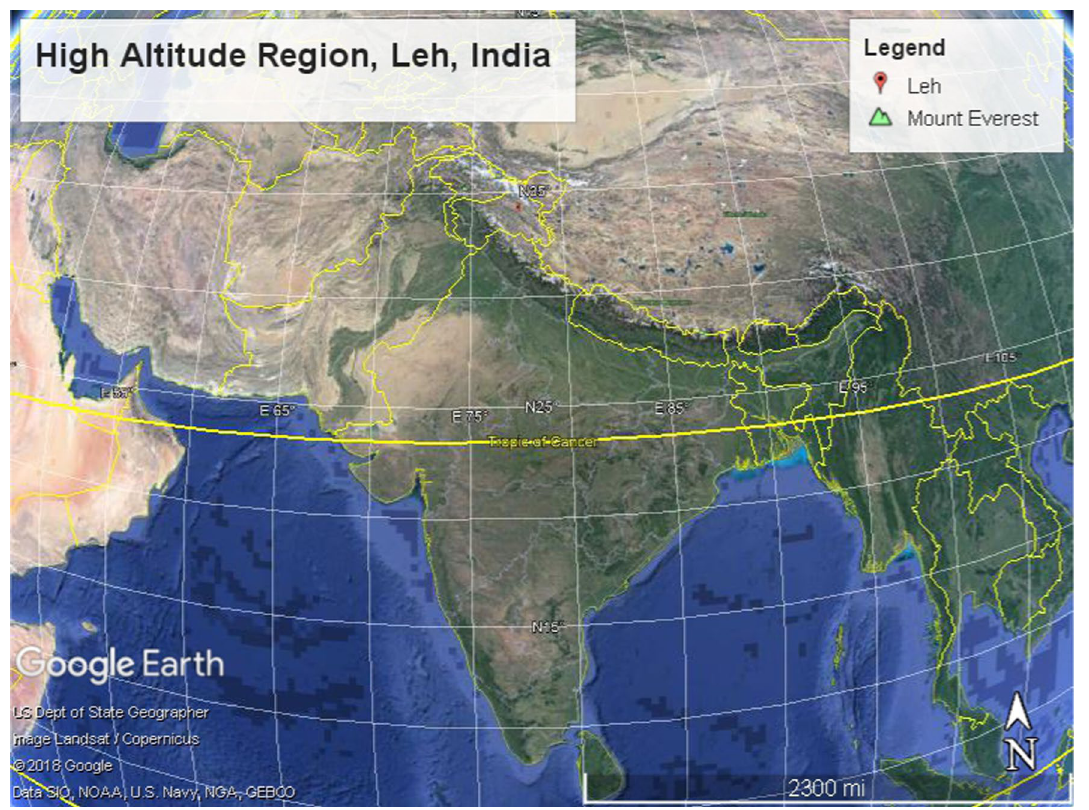
Fig. 2 Experimental location in Leh, a high-altitude region of India. Map prepared using Google Earth 3D Pro